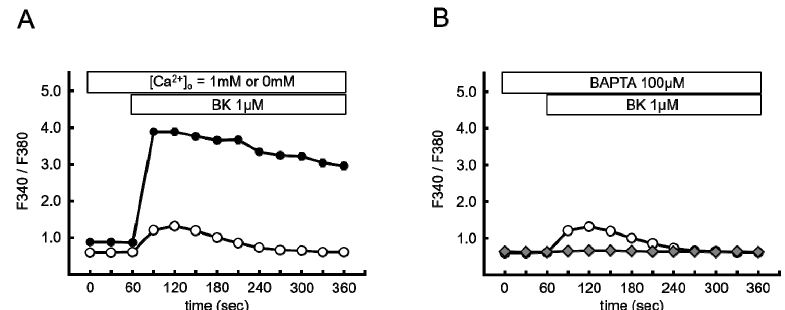
Figure 1. Bradykinin (BK) increased cytosolic Ca 2+ concentration. ( A ) Time course of changes in the fluorescence ratio (F340/F380) of fura-2 in Ca 2+ -free (open circle; n = 255) and 1 mM Ca 2+ (closed circle; n = 210) modified Tyrode’s solution. ( B ) The same experiment as ( A ) conducted in Ca 2+ -free modified Tyrode’s solution with (open circle; n = 255) or without 1,2-Bis (2 aminophenoxy) ethane-N,N,N’,N-tetraacetic acid tetraacetoxymethyl ester (BAPTA) (closed diamond; n = 203). Data are expressed as the mean ± standard error of the mean (SEM) of three independent experiments in separate cell culture wells.